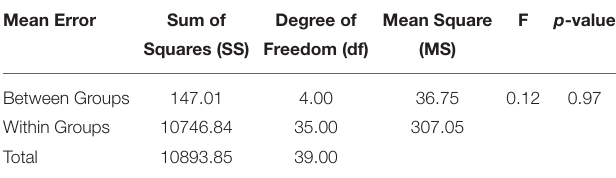
TABLE 5 | Results of ANOVA for the mean errors between prototype